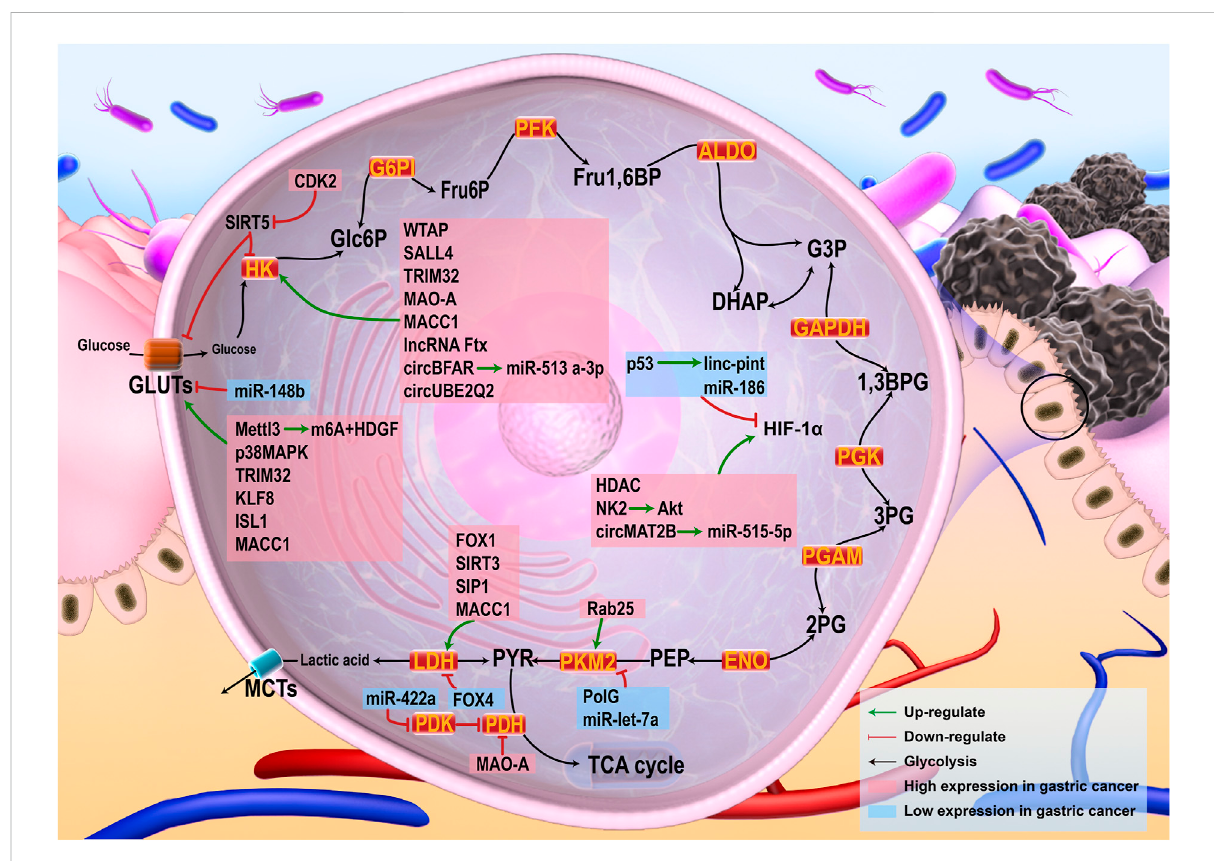
FIGURE 1 Glycolysis in cancer cells and the related regulatory pathways. Glucose was uptaken into cells by GLUTs, where it is metabolized into pyruvic acid by a series of enzyme reactions. Pyruvic acid could be metabolized by LDH to lactic acid out of the cells, or by PDH to acetyl-CoA into the TCA cycle when oxygen supply is adequate. HIF-1, the main regulator of glycolysis, was able to up-regulate the expression of a variety of enzymes in the glycolysis process. Multiple tumor-related pathways were involved in regulating glycolysis of gastric cancer. Factors with high expression in gastric cancer, such as HDAC and WTAP, can directly promote glycolysis of gastric cancer by up-regulating the expression of glycolysis-related proteins or enzymes. Some factors that can inhibit glycolysis-related enzymes, such as FOX4, miR-186, etc. , were low expressed in gastric